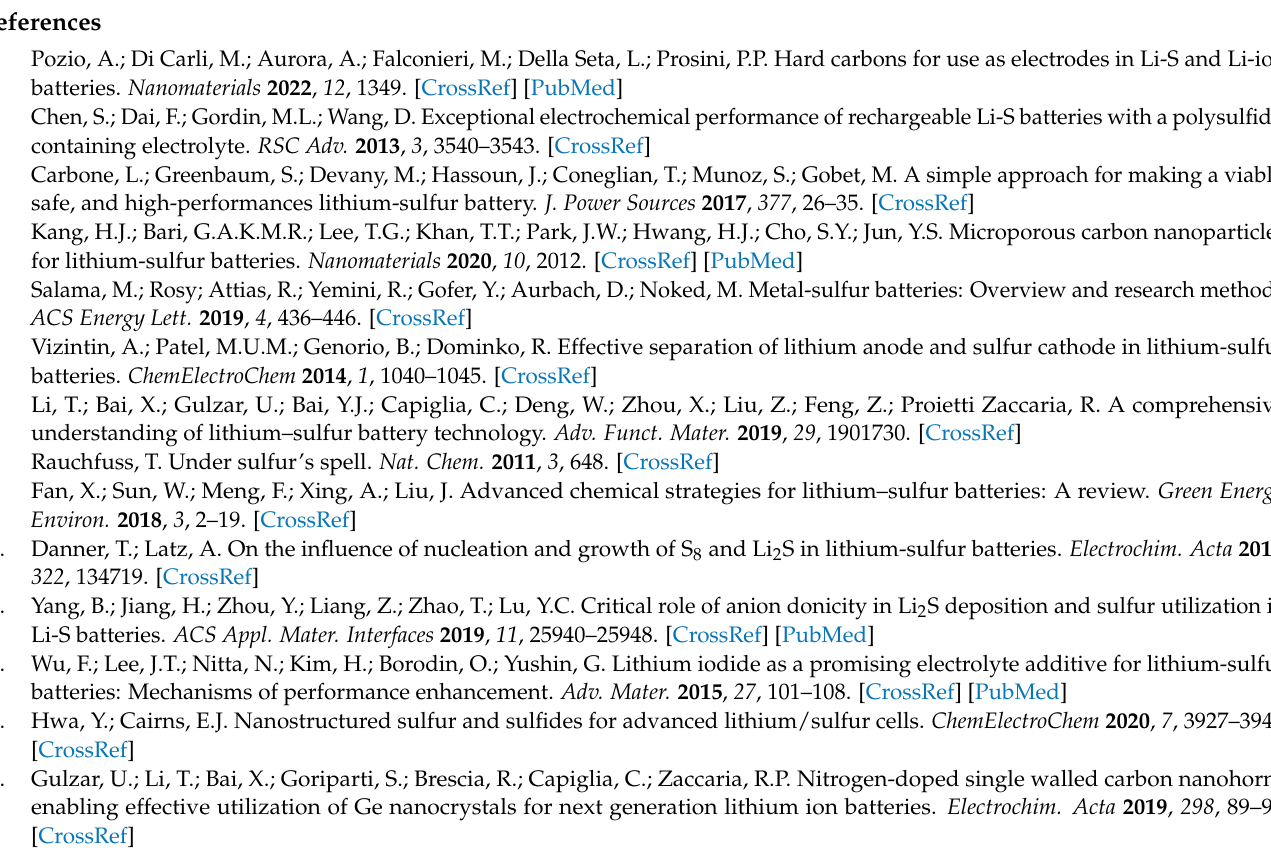
pre-treatment; Figure S2: SEM images of the sulfur electrode surface and cross-section; Figure S3: determination; Figure S4: Comparison of electrolytes’ conductivity values upon cooling; Figure